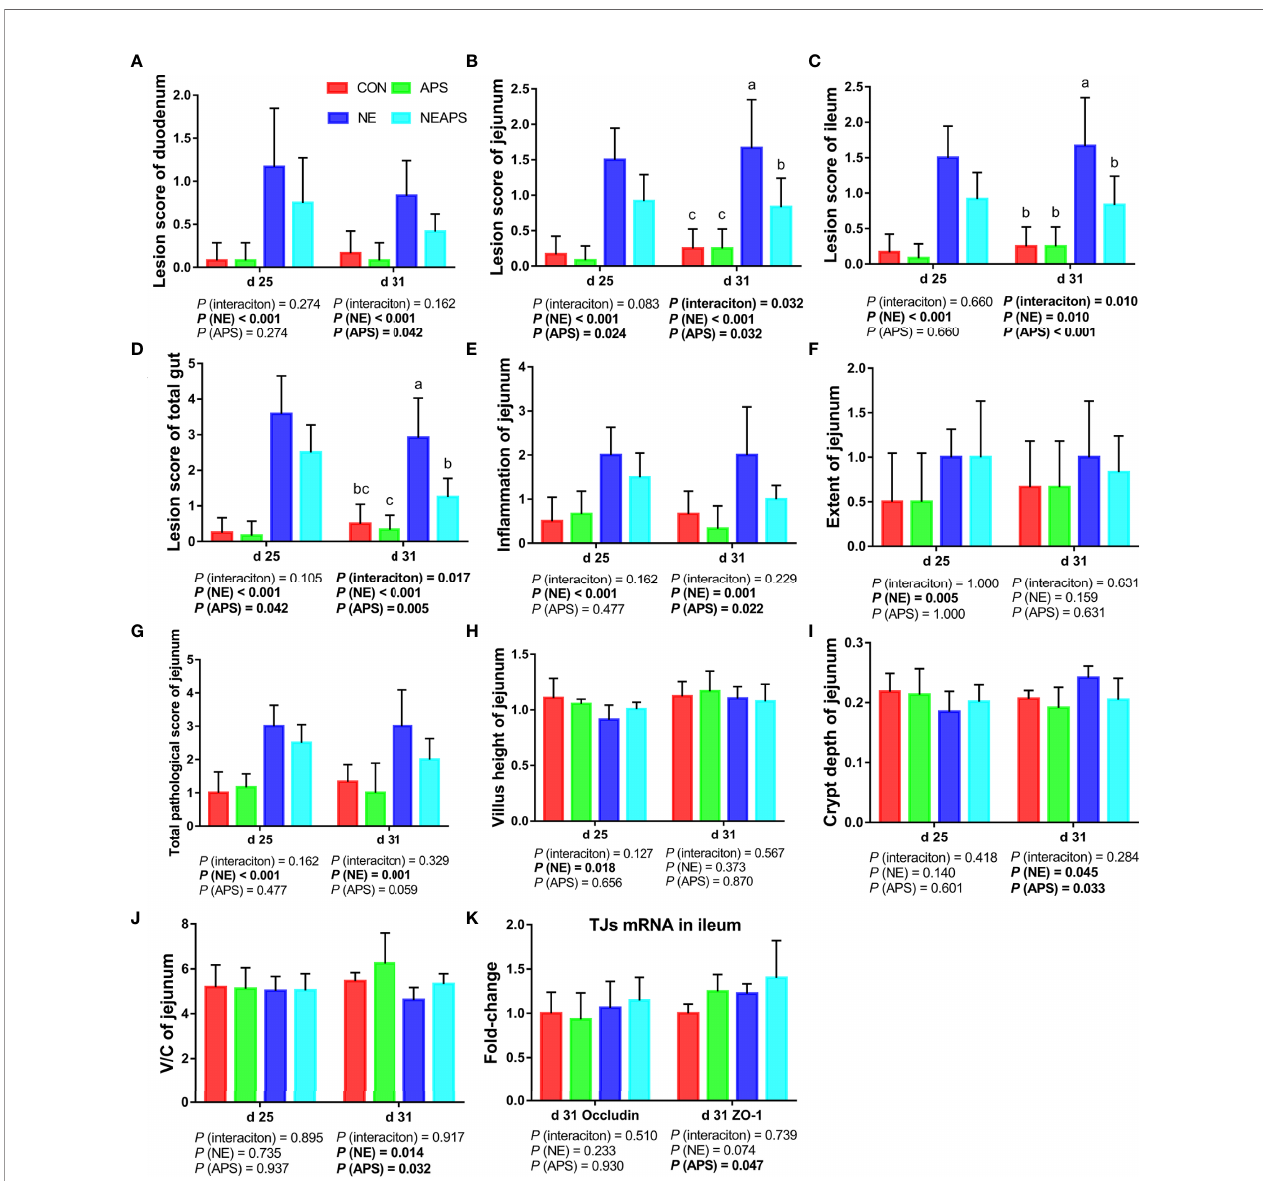
FIGURE 4 | Effects of astragalus polysaccharide supplementation on intestinal lesion score, pathology score and intestinal tissue morphology of broiler chickens challenged with necrotic enteritis. The lesion scores of duodenum (A) , jejunum (B) , ileum (C) and total gut (D) were analyzed as described in the Materials and Methods section. The in fl ammation of jejunum (E) , extent of jejunum (F) and total pathological score of jejunum (G) were analyzed as described in the Materials and Methods section. The villus height of jejunum (H) and crypt depth (I) of jejunum were analyzed by HE staining. The V/C of jejunum (J) was calculated by dividing the villus height by the crypt depth. The mRNA levels of Occludin and ZO-1 in ileum (K) were analyzed by RT-PCR. All graphs are presented as mean, with the standard deviation (SD) shown via the whiskers. The main effect and interaction effects were analyzed using the general linear model (GLM) procedure, with the P values for the main effects written out below each plot. The one-way ANOVA and multiple comparisons were performed when interactive effects differed signi fi cantly. The lowercase letters on the bar charts indicate signi fi cant differences ( P < 0.05). CON, control group; APS, APS group; NE, NE infection group; NEAPS, APS infected with NE